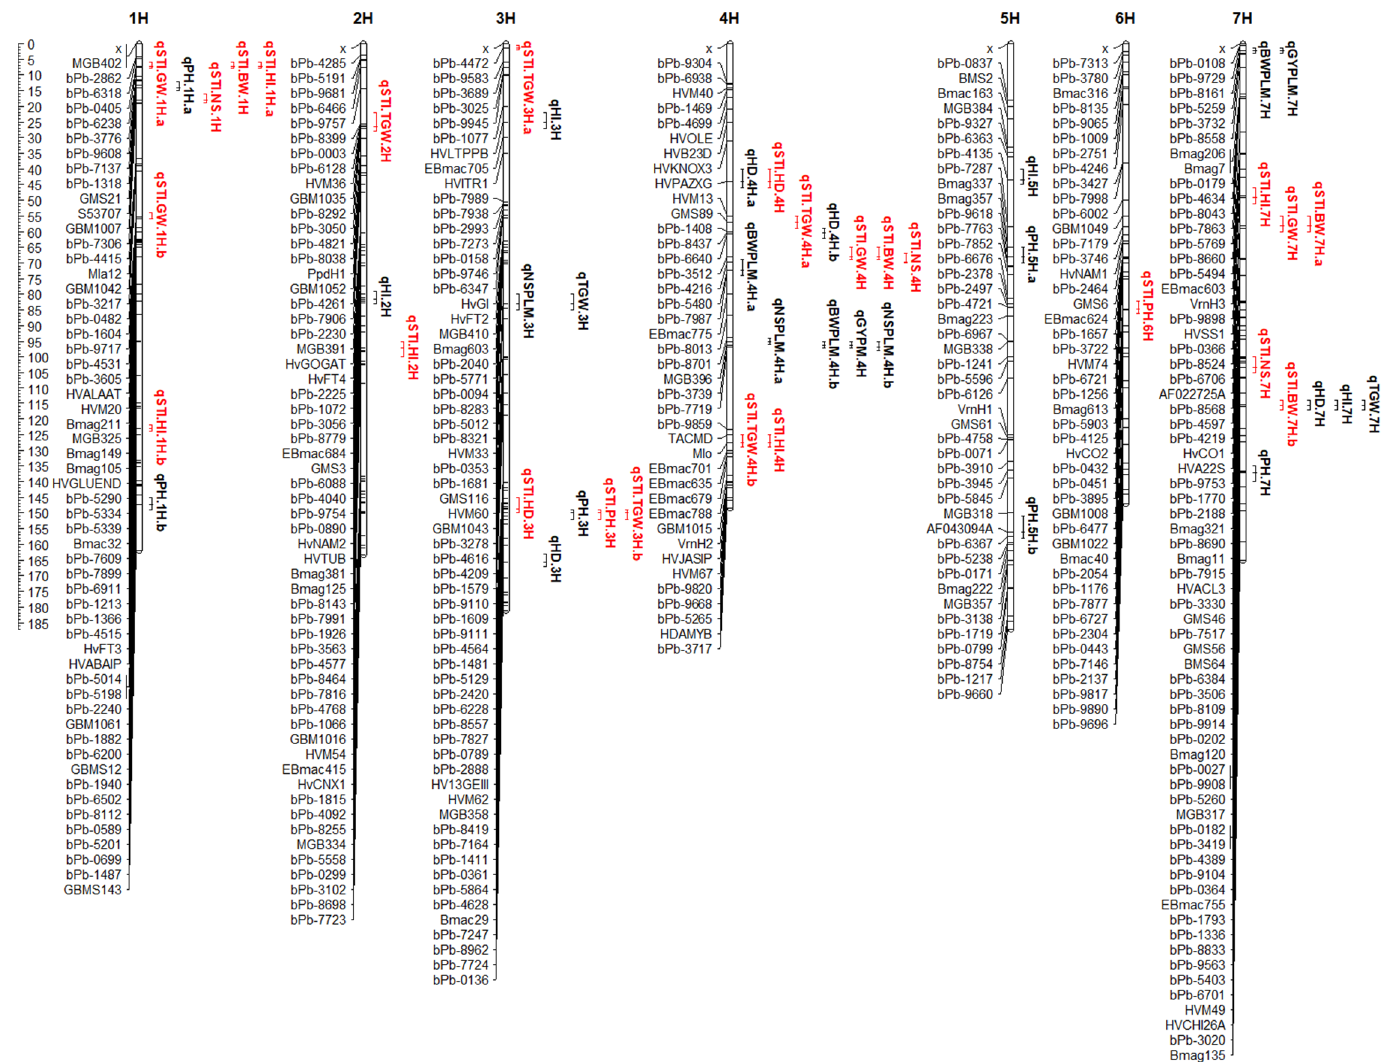
Figure 1. Localization of detected QTL for grain weight and its attributes along with QTL mapped for salinity tolerance index (red color).